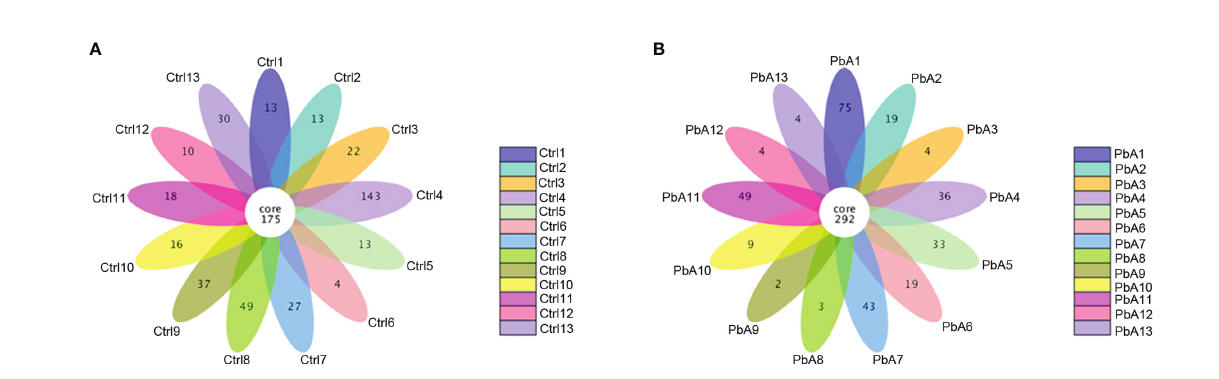
FIGURE 2 | Operational taxonomic unit (OTU) analysis in the different fecal samples. (A) Flower diagram showing the shared and unique OTUs in the Ctrl samples. (B) Flower diagram showing the exclusive and mutual OTUs in the PbA samples.